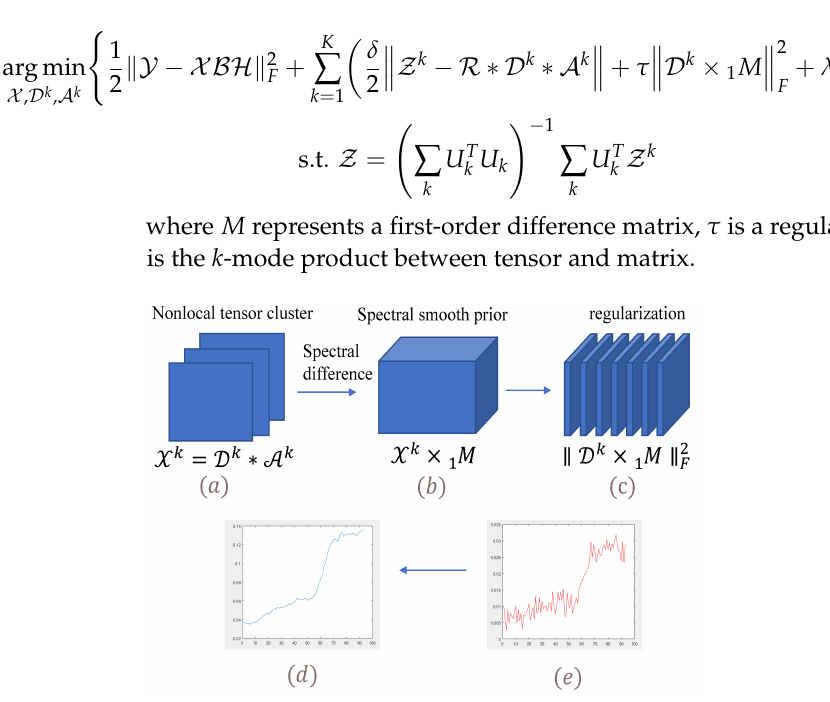
Figure 3. Spectral smoothing regularization term and restoration results of the spectrum at location (2,2). ( a ) Fidelity term with tensor decomposition X k = D k ∗ A k . ( b ) Image obtained by spectral difference operator. ( c ) Spectral smoothing regularization term on the sub-tensor D k . ( d ) spectral curve with spectral-smoothness constraint. ( e ) spectral curve without spectral-smoothness